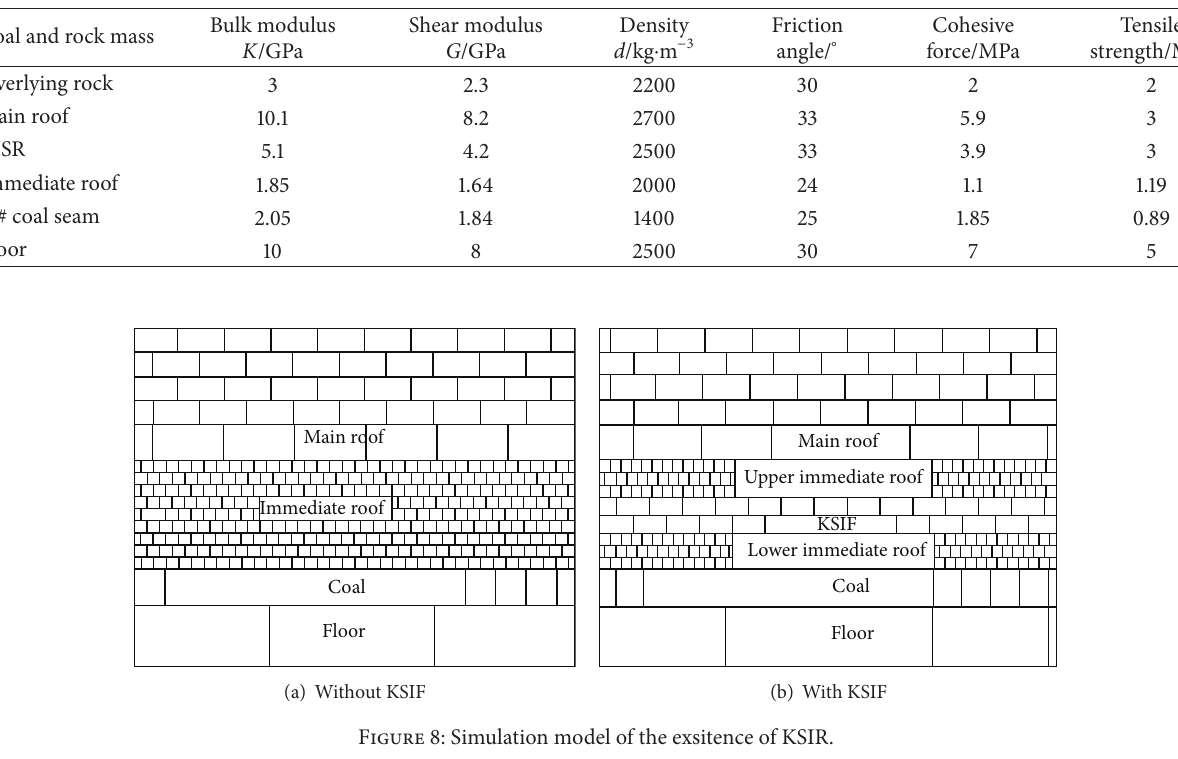
Table 3: Mechanical properties of numerical model.